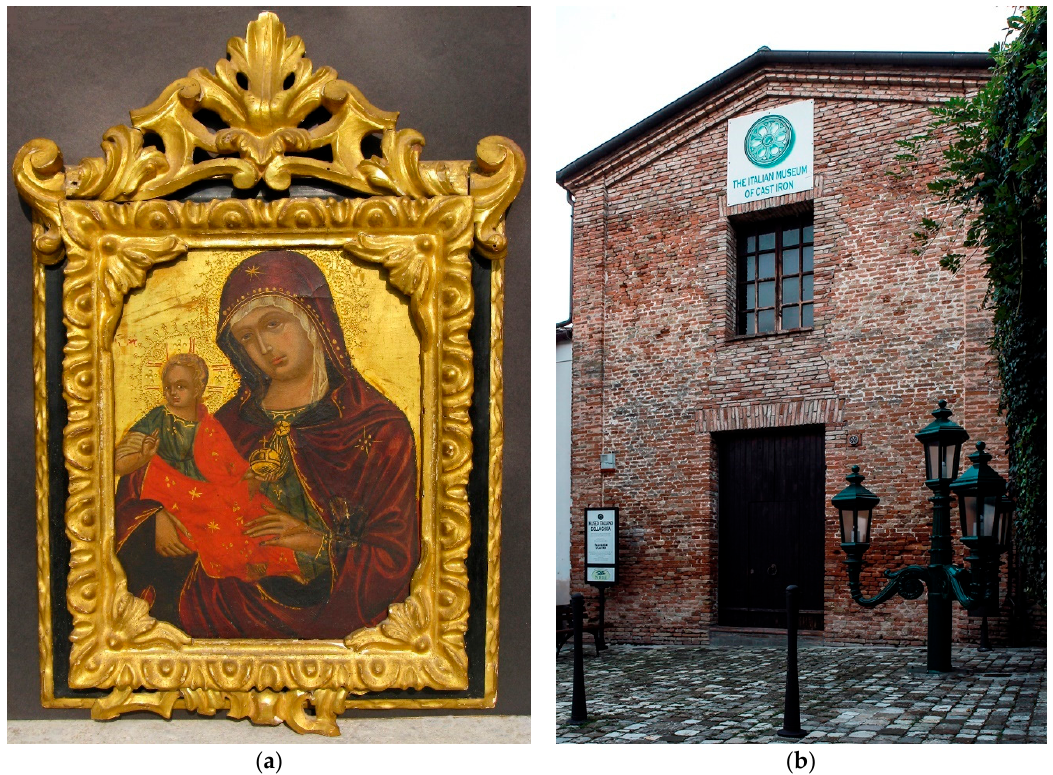
Figure 1. ( a ) Madre della Consolazione (Madonna delle Lacrime), ca. 1500, © Longiano, Museo d’Arte Sacra; ( b ) Ex Church of Santa Maria delle Lacrime, now Museo Italiano della Ghisa, Longiano (image in the public domain).